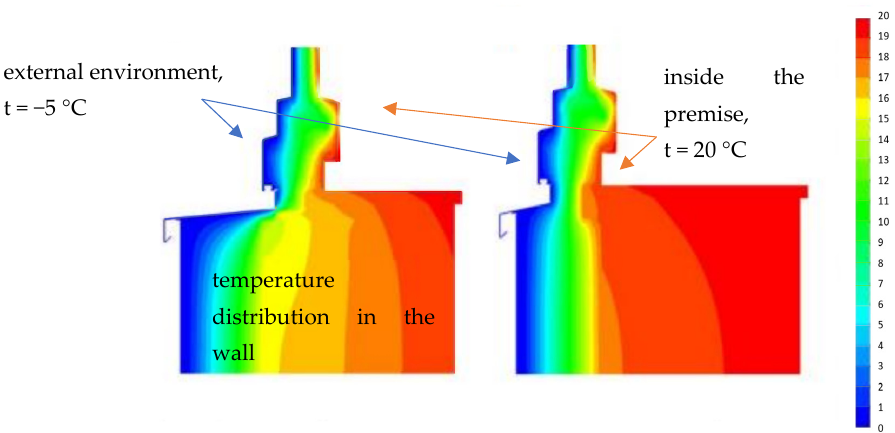
Figure 13. The temperature distribution in walls and windows depending on the location of the window (author data).